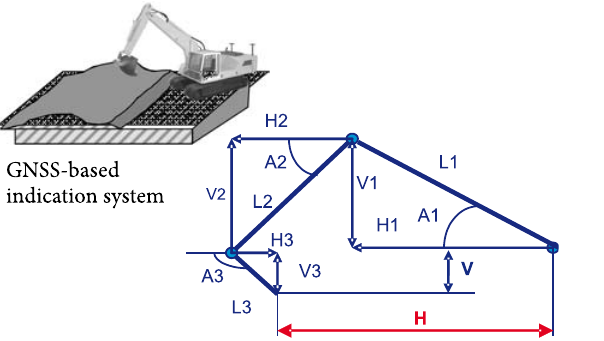
Fig. 4. 3D Control, example of a mainline paver (Stempfhuber